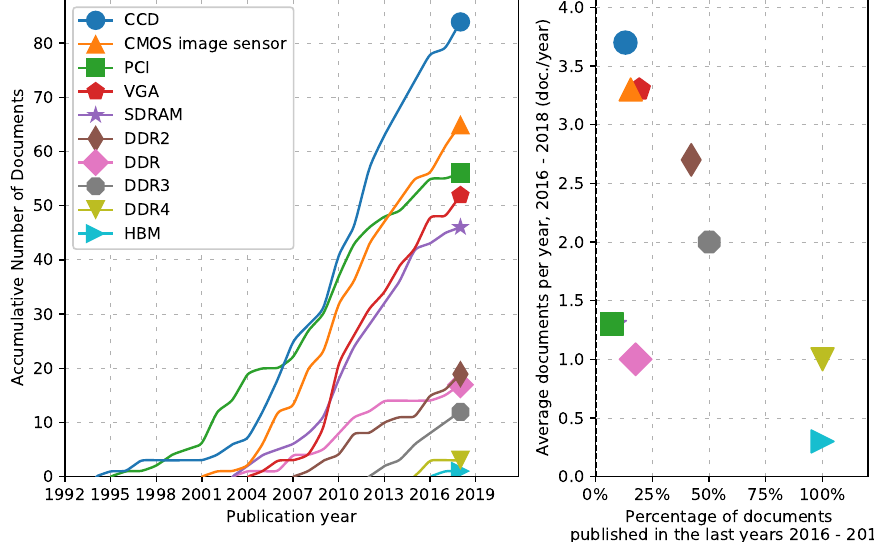
Figure 4. Parallel communication interfaces top implementations in FPGA